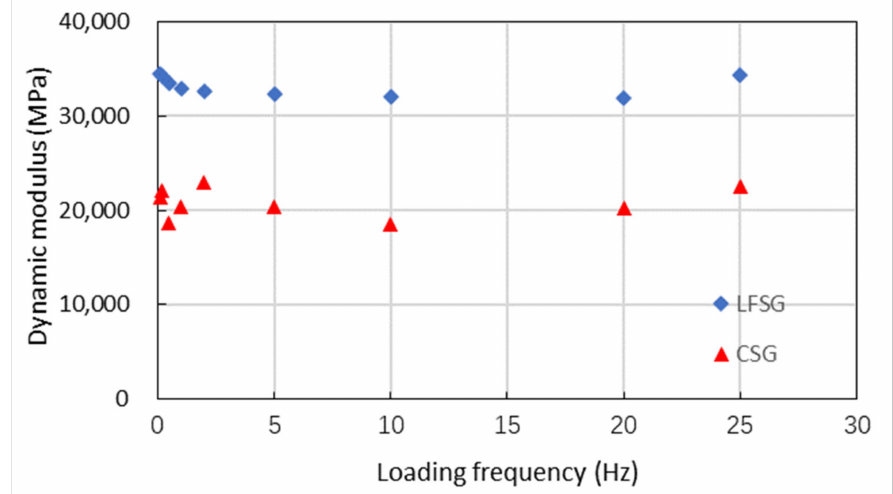
Figure 4. Dynamic modulus of CSG and LSFG.